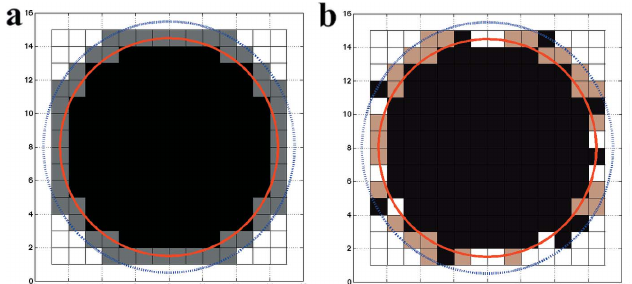
Figure 1 Schematic drawings of crystal boundary ( a ) and an example of crystal composition ( b ). In ( a ), the boundary is defined to be the unit cells in between the two circles (red and blue); the unit cells are colored in grey. In ( b ), the state of boundary unit cells is assigned randomly: full (black), unoccupied (white) and brown (partial). The ratio of three unit-cell states at the boundary is 1:2:1 in ( b ), i.e. , 1/3 of the boundary for each